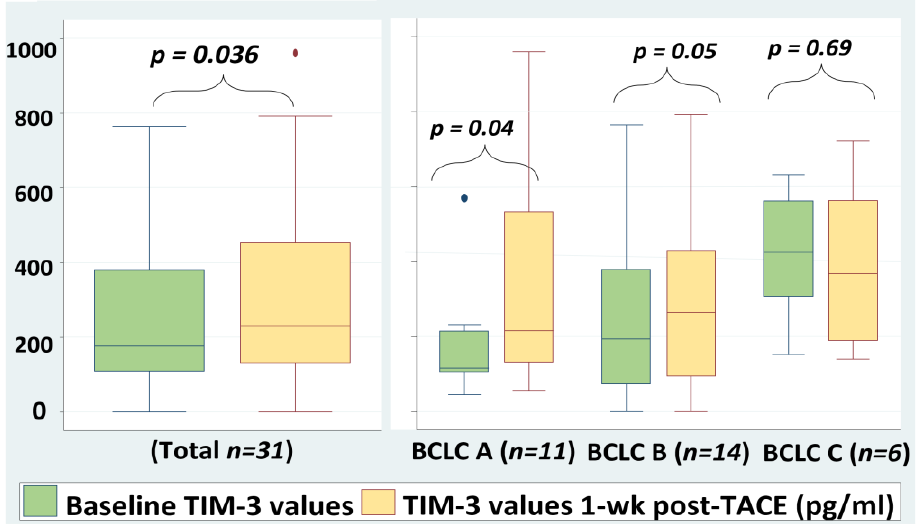
Figure 3. Serum TIM-3 values pre- and 1-week post-TACE. Wilcoxon test was used for the comparison of sTIM-3 values. Outliers were excluded from the analysis. sTIM-3; serum T-cell immunoglobulin and mucin domain-3, TACE; transarterial chemoembolization, BCLC; Barcelona Clinic Liver Cancer.